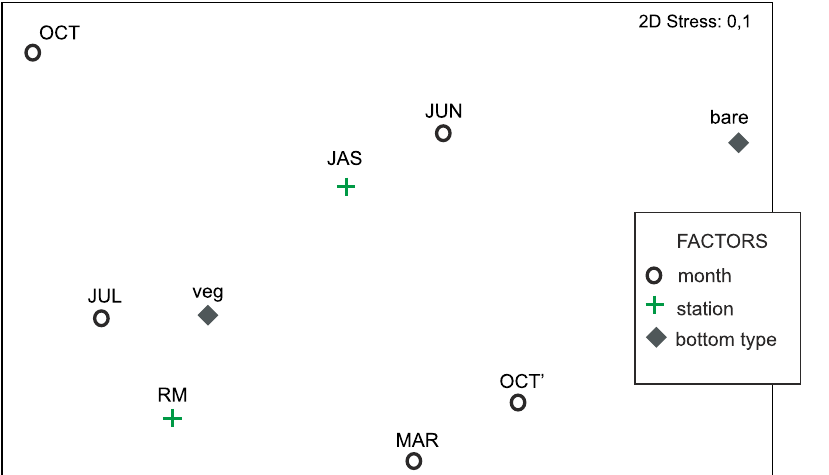
Figure 5. nMDS plots of Bray-Curtis similarities of average species abundances computed for groups of samples representing months, stations, bottom types. Data were double root transformed.